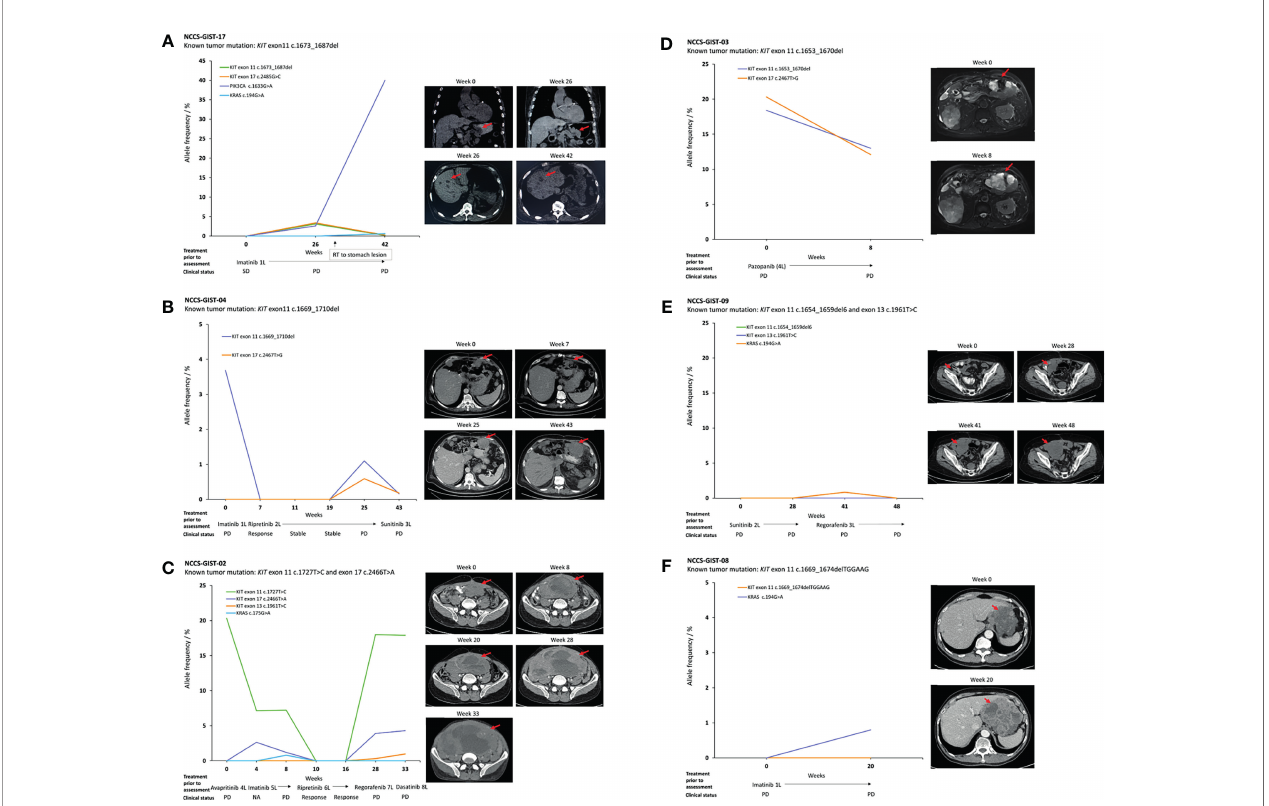
FIGURE 3 | Temporal correlation of ctDNA mutations and patients with advanced GIST progressing while on TKI therapy. (A) Detectable KIT exon 11 and 17 mutations, as well as a potentially actionable PI3K3CA c.1633G>A mutation upon disease progression. The PI3K3CA variant was dominant over other mutations in ctDNA on further disease progression. (B – D) Trajectory and correlation of ctDNA variants with disease status. (E, F) Non-detection of KIT mutations in ctDNA despite disease progression. Each fi gure is accompanied with the CT scans taken at the indicated time points. The red arrows refer to the location of the tumor. SD, stable disease; PD progressive